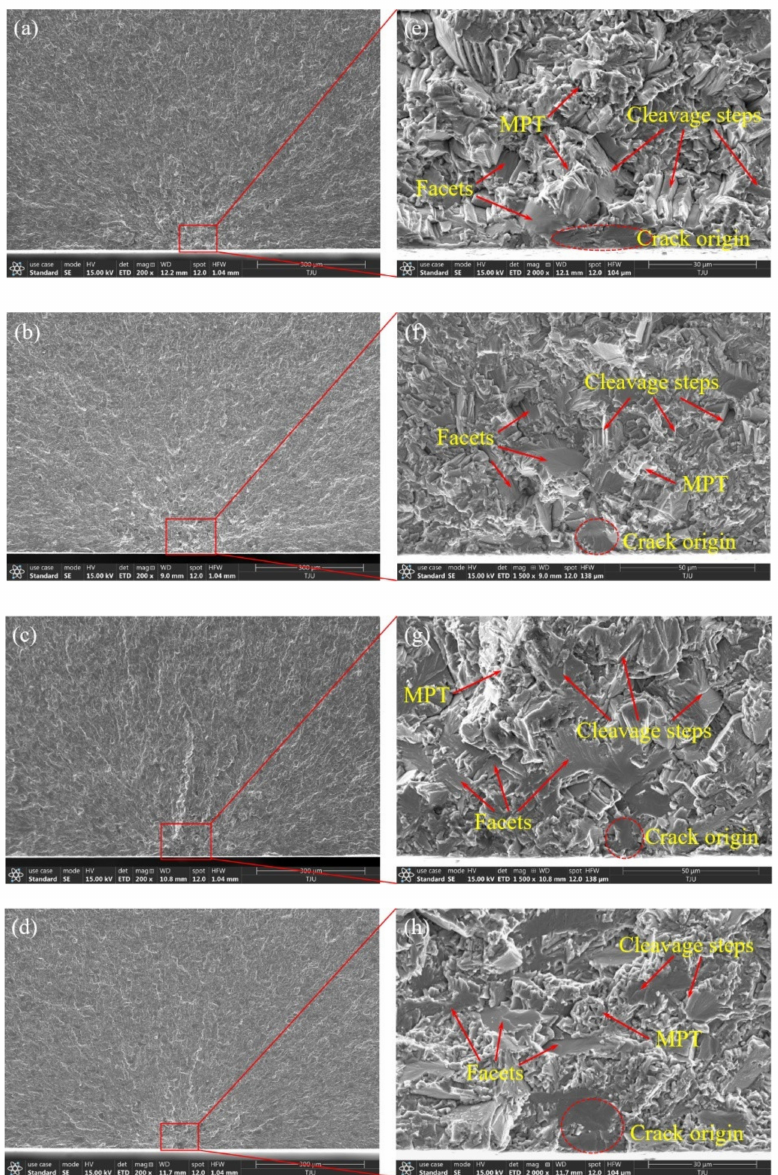
Figure 7. SEM morphology of high-cycle-fatigue crack origin zone. ( a , e ) Equiaxed I, σ a = 330 MPa, N f = 1.26 × 10 6 ; ( b , f ) equiaxed II, σ a = 300 MPa, N f = 4.25 × 10 6 ; ( c , g ) bimodal I, σ a = 285 MPa, N f = 5.08 × 10 6 ; ( d , h ) bimodal II, σ a = 270 MPa, N f = 6.39 × 10 6